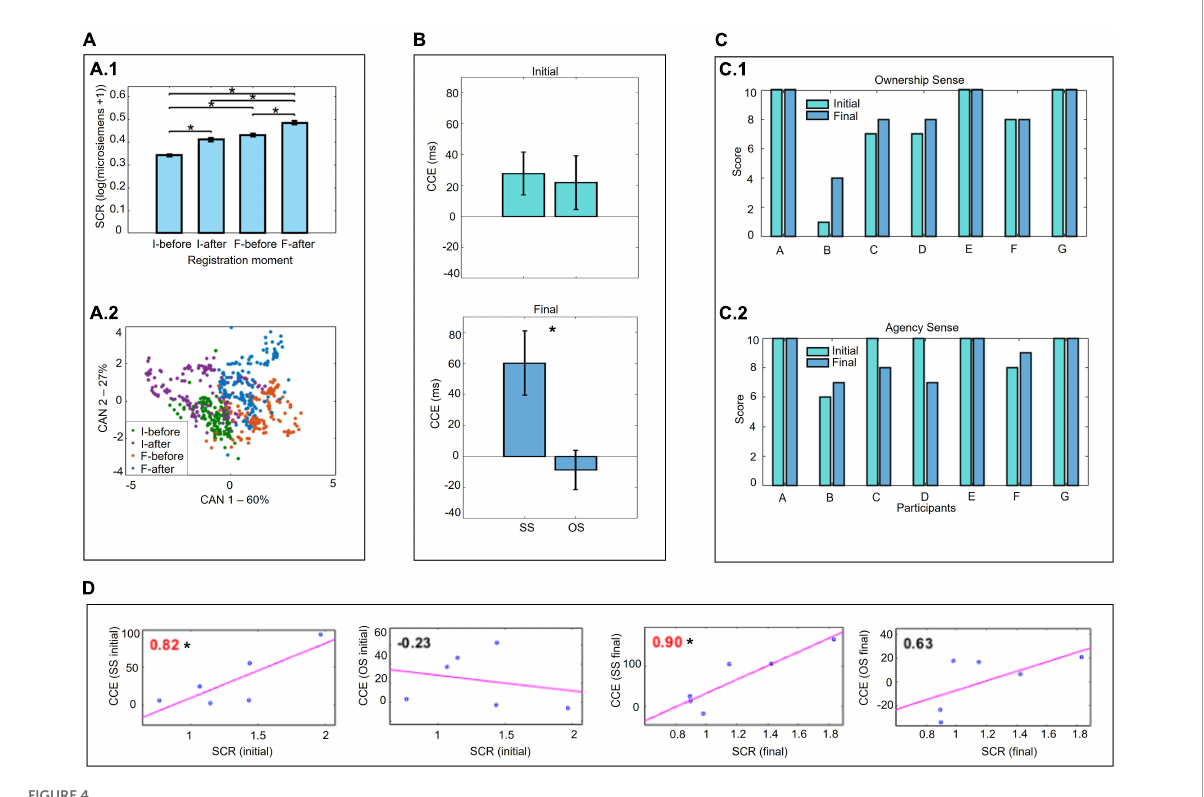
FIGURE4 Affective, spatial perception measurements, and self-perception. (A) Skin conductance response (SCR) to a threat to the virtual prosthesis. (A.1) Two-way ANOVA with Tukey-Kramer correction. (A.2) Application of one-way MANOVA followed by canonical discriminant analysis. (B) Crossmodal congruency task (CCT) and crossmodal congruency effect (CCE) (two-way ANOVA with Tukey-Kramer correction). Comparison for stimuli applied on the same side (SS) and opposite side (OS). (C) Self-perception (absolute values quantified by the participants). (C.1) Sense of ownership. (C.2) Sense of agency. (D) Correlations between the SCR and CCE results (Pearson’s correlation coefficients). * p <